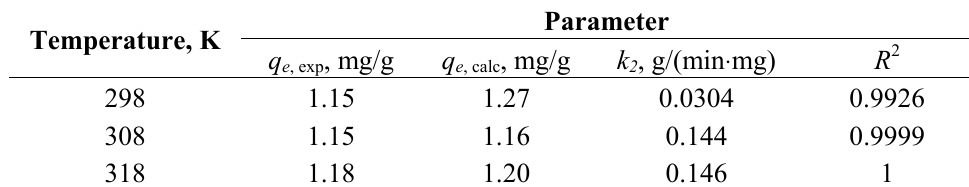
Table 4. Pseudo-second-order parameters for Cs + adsorption onto Florisil ® impregnated with